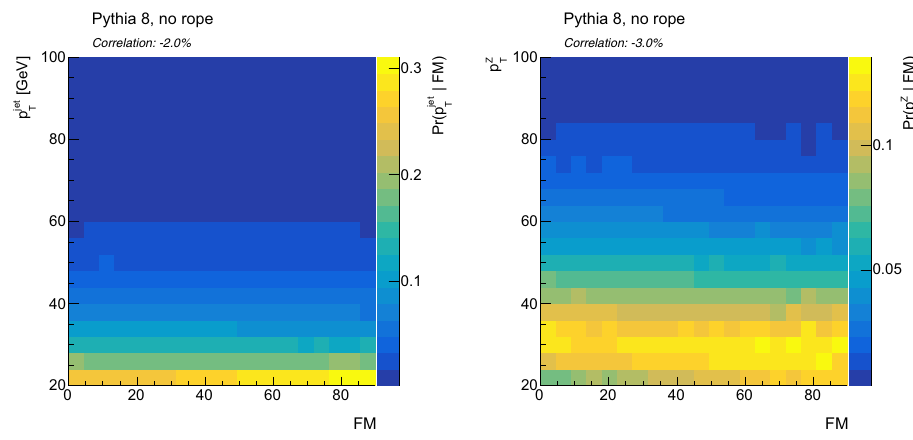
Fig. 8 The distribution of the jet (left) or Z boson (right) p T given the event multiplicity defined by FM. The linear correlation coefficient is presented at the top of each plot. The corresponding plots for TTM and ZTM are shown in the appendix, Fig. 17